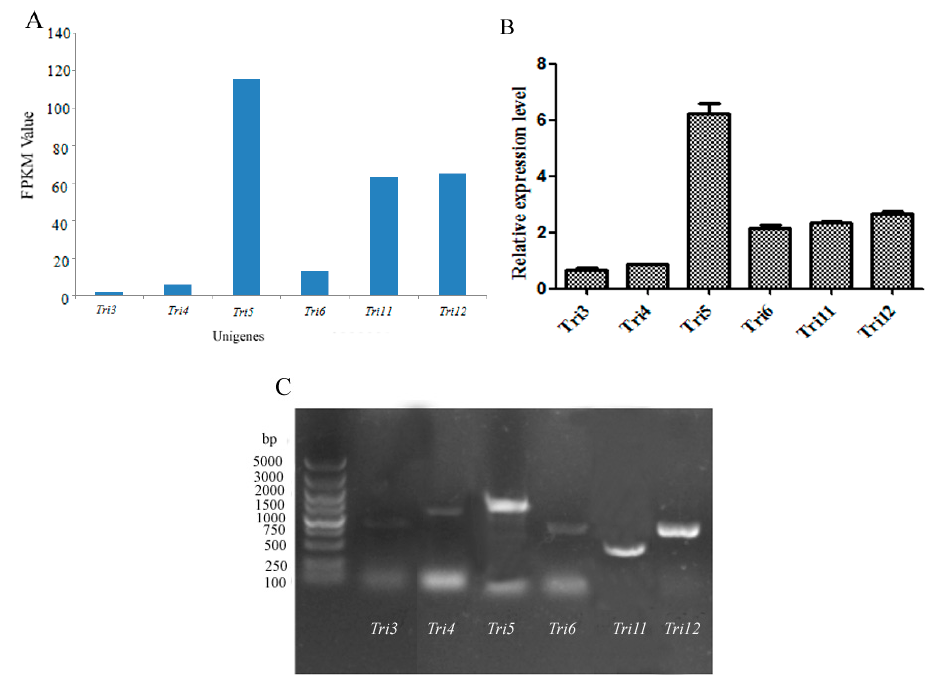
Figure 4. Identification of unigenes involved in trichothecene biosynthesis in M. roridum : ( A ) prediction of expression levels of unigenes involved in trichothecene biosynthesis according to the FPKM value; ( B ) validation of expression levels of unigenes involved in trichothecene biosynthesis by qRT-PCR; ( C ) agarose electrophoresis of qRT-PCR products of unigenes involved in trichothecene biosynthesis.